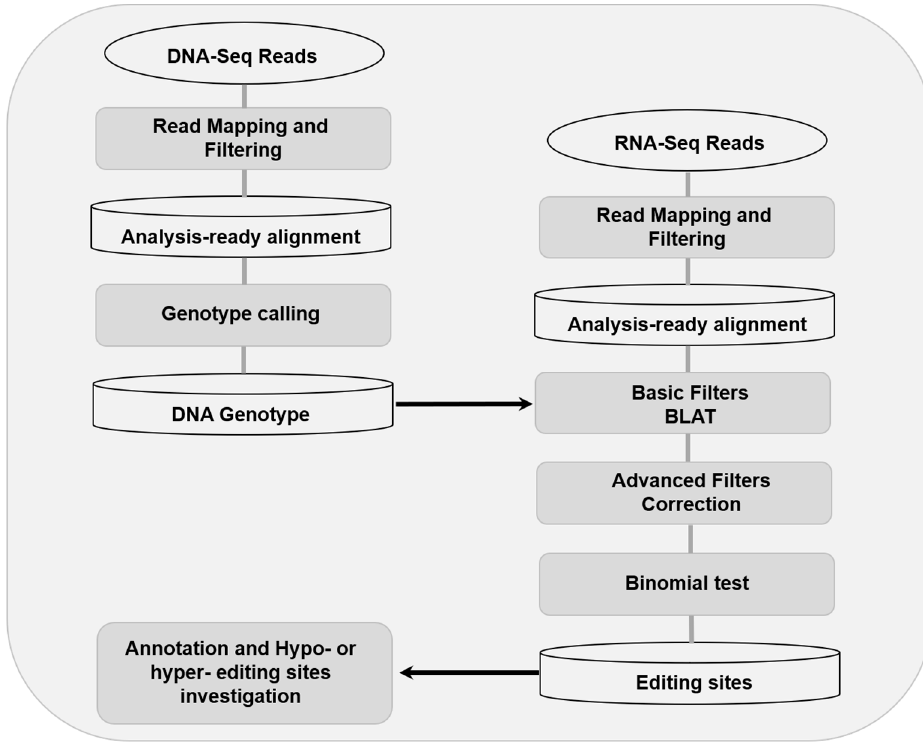
Figure 1. Overview of the workflow of RNA editing sites detection.